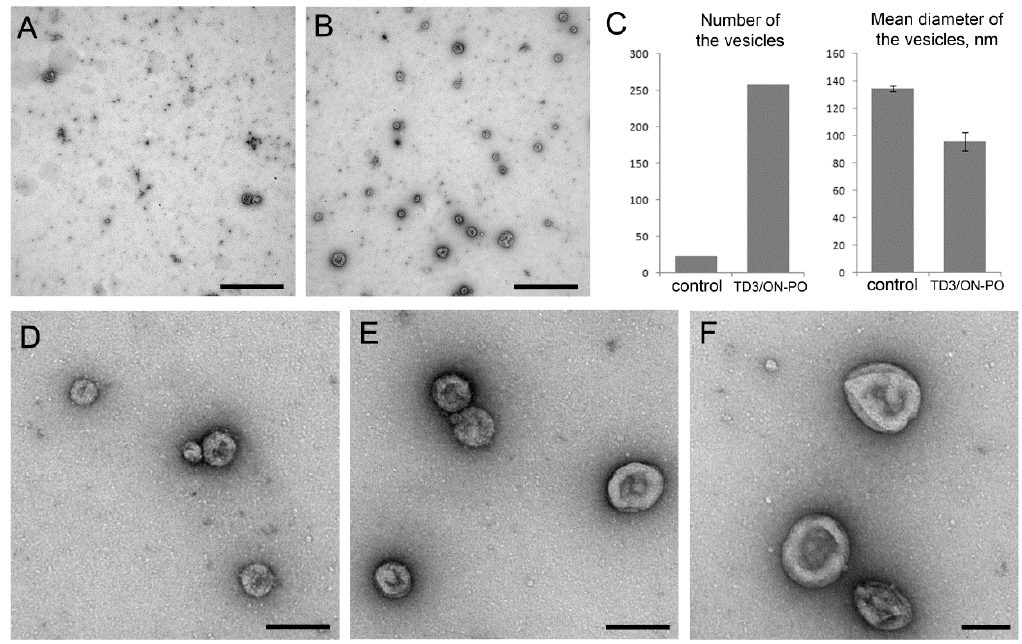
Figure 10. Transmission electron microscopic study of extracellular vesicles. ( A , B ) The abundance of vesicles in control cells and cells incubated with TD3/ON-PO duplexes, respectively. ( C ) The quantification of number and diameter of vesicles on three different (10 × 10 µm) areas of the grid. ( D – F ) Diameter variations of vesicles in the pellet from cells incubated with TD3/ON-PO duplexes. Scale bars: 1 µm ( A , B ), 100 nm ( D – F ).